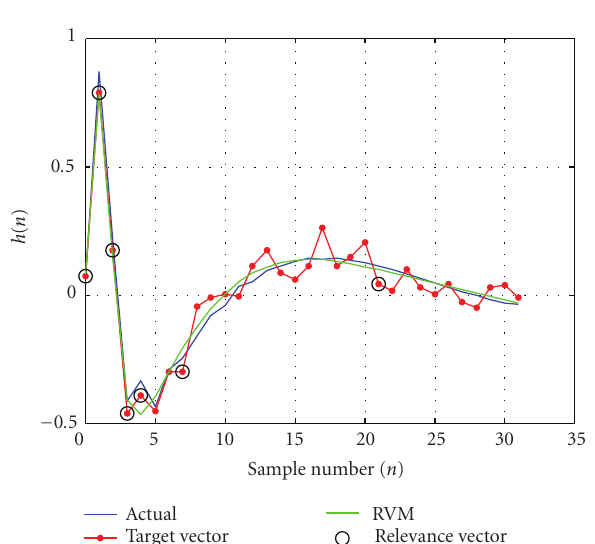
Figure 4: Channel impulse response and its estimate obtained using the RVM method.